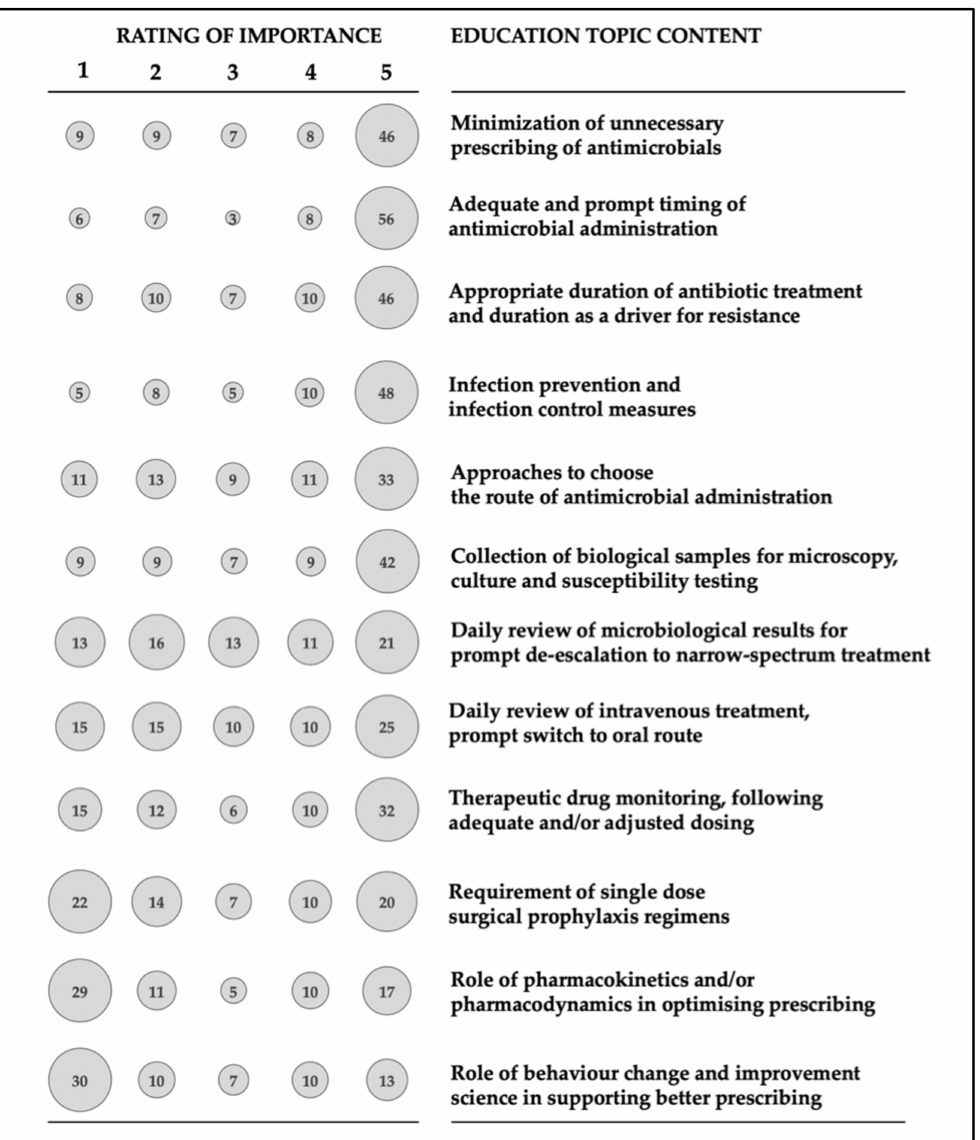
Figure 2. Ratings (1—lowest, 5—highest) for preferred topic content during antimicrobial stewardship education and training. Percentages are depicted above each column; all remaining respondents (up to the total of 100%) did not rate the option during the